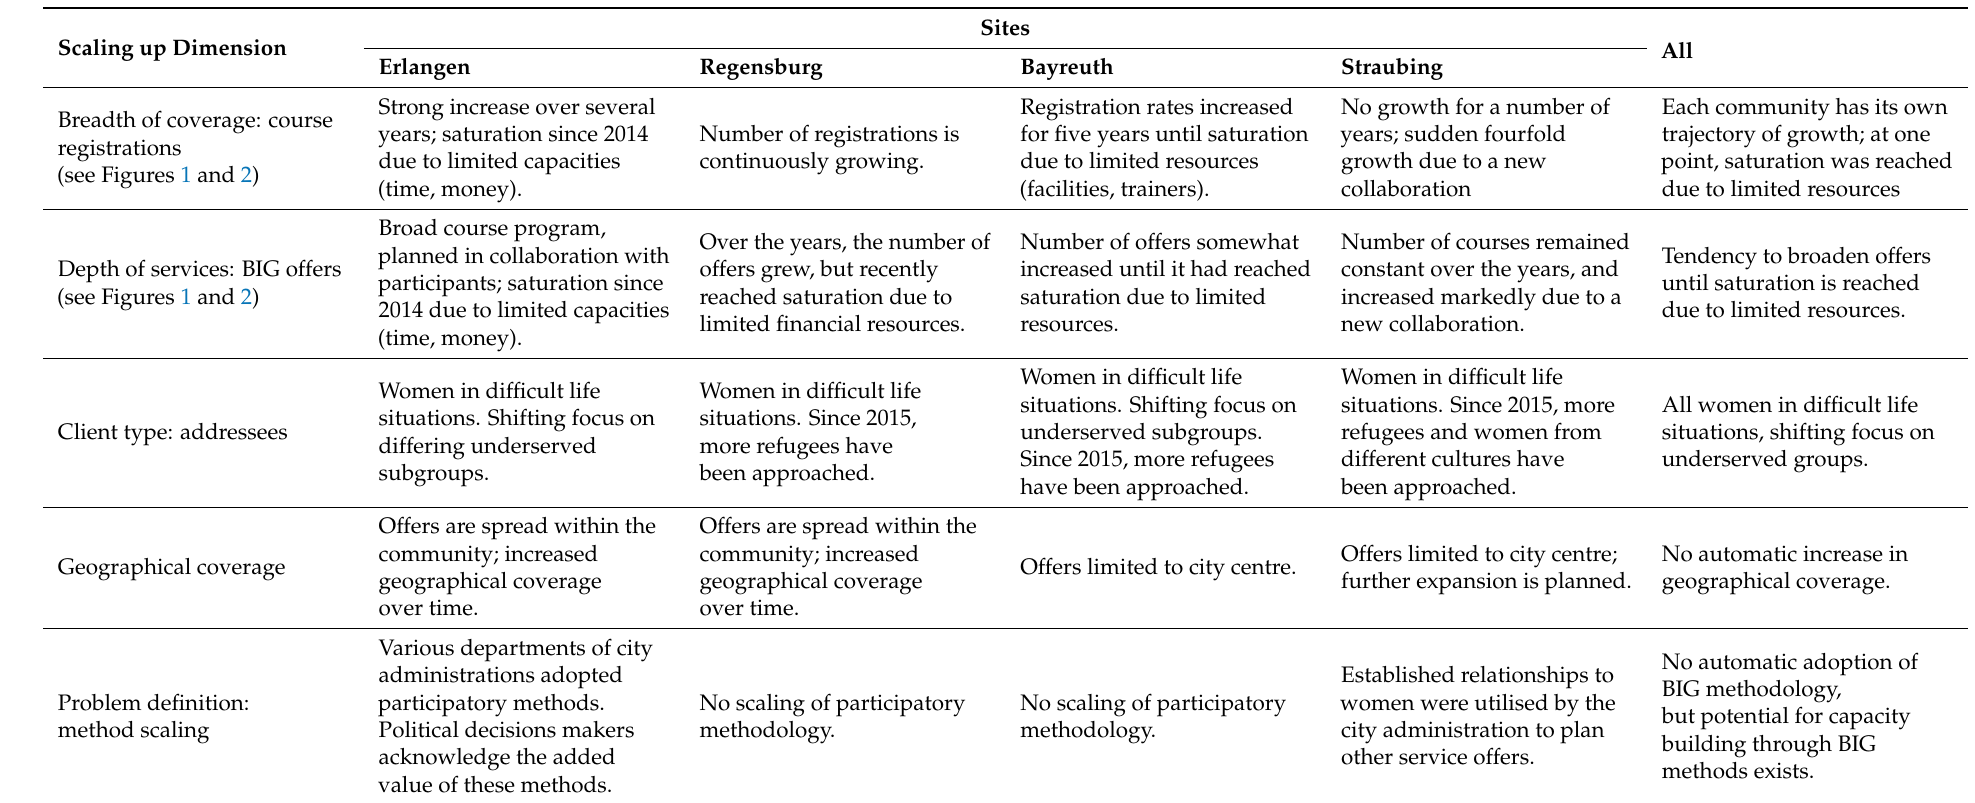
Table 3. Summary of main